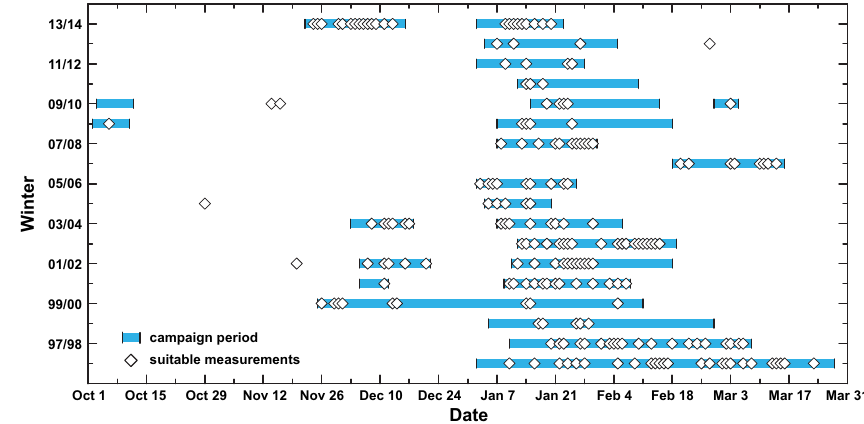
Figure 2. Range of measurement campaigns (marked by colored bars) and nights with suitable measurements for gravity wave analysis